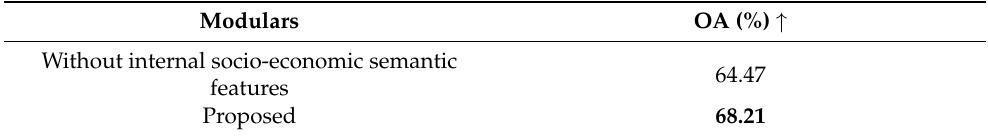
Table 6. Influence of internal socio-economic semantic